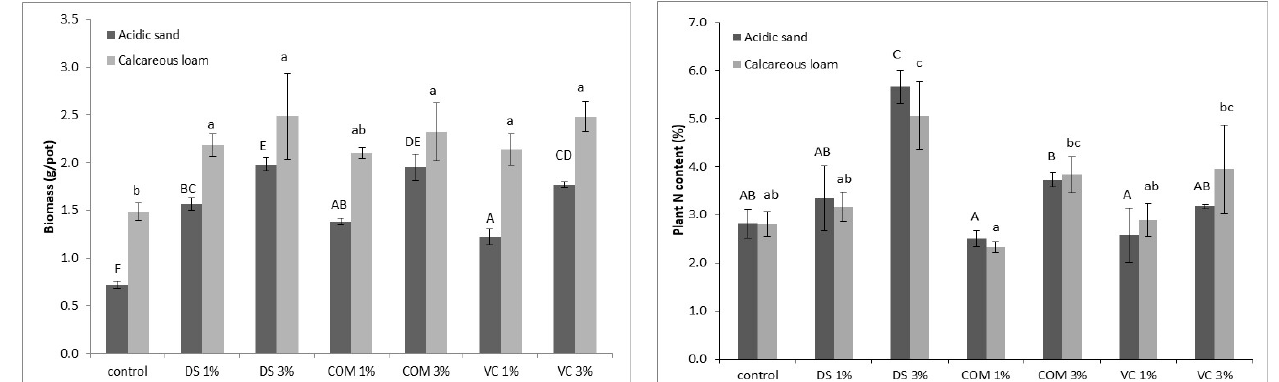
Figure 5. Changes in the aboveground biomass and N content of perennial ryegrass two months after sowing on soils treated with digested sludge (DS), digested sludge compost (COM), and digested sludge vermicompost (VC) in 1% and 3% doses. Error bars represent the standard deviation (SD) of the mean with 3 replicates. Uppercase letters indicate significant differences between treatments on acidic sand and lowercase letters indicate significant differences between treatments on calcareous loam ( p < 0.05). Table 4. Correlation coefficients between soil nutrient contents and the aboveground biomass of perennial ryegrass on the investigated soils.